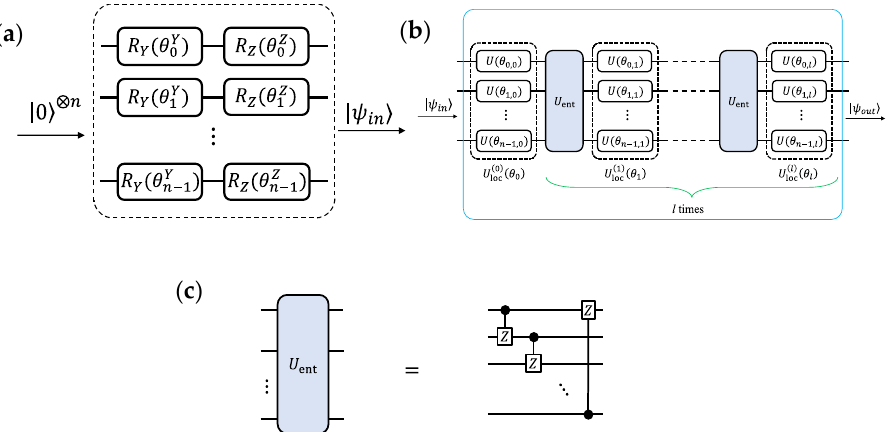
Figure 2. ( a ) Preparation of input state by a unitary input gate U in ( x ) exemplified by a series of rotation gates. ( b ) Quantum circuit to present variational parameter state W ( θ ) . l denotes the depth of the quantum circuit. ( c ) Quantum entanglement circuit where U ent gate is composed of CZ gates from qubit j to qubit ( j + 1) mod n , j ∈ { 0, . . . , n − 1 } .